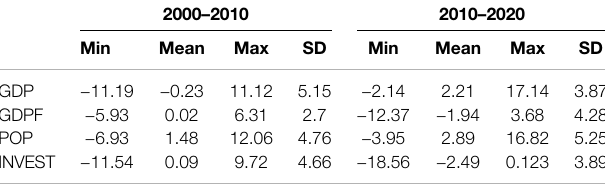
TABLE 5 | Summary of the estimated coef fi cients detected by the GWR